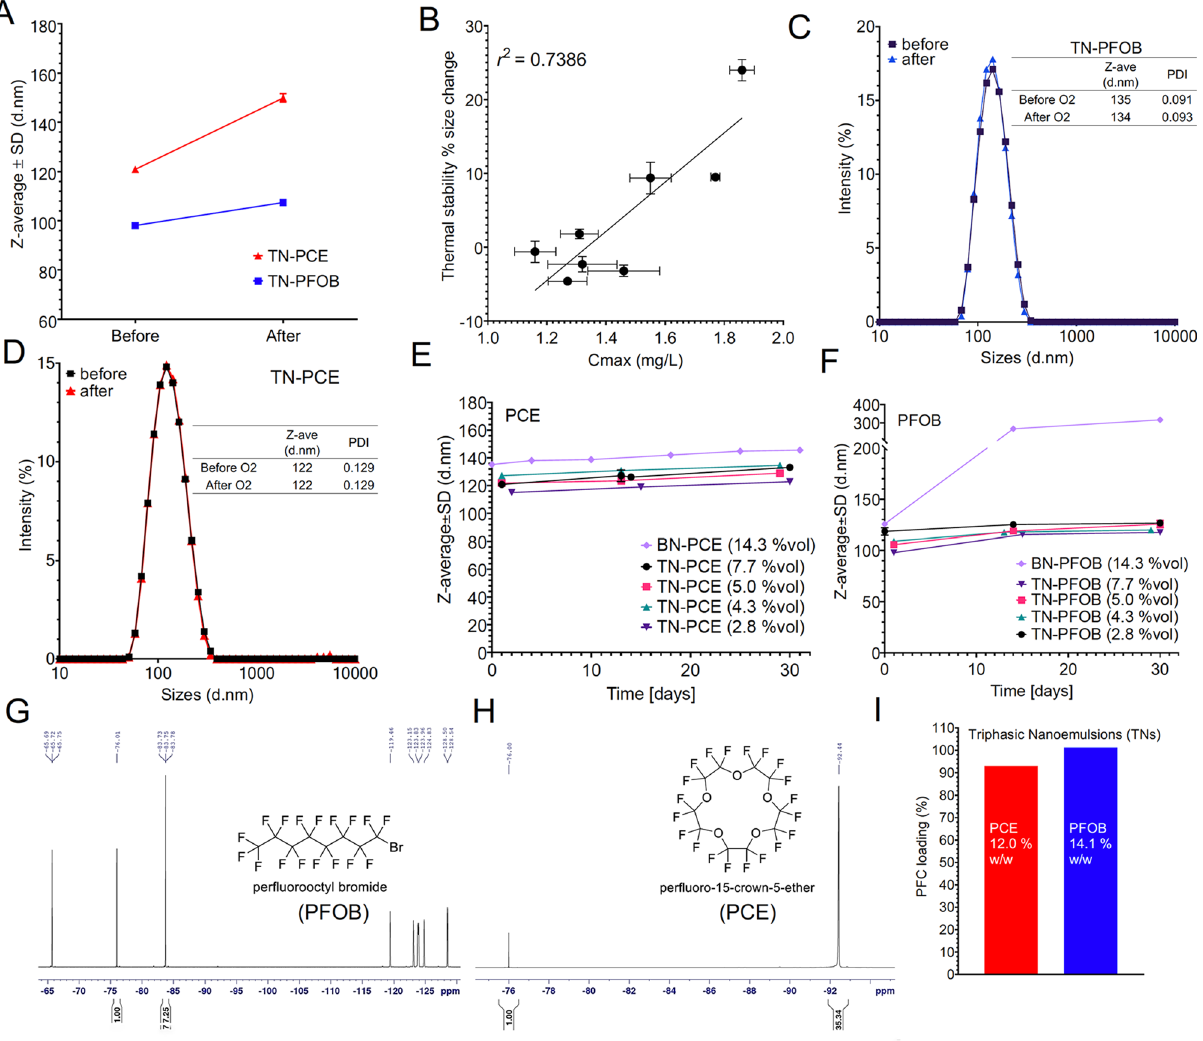
Figure 5. Characterization of triphasic PFC nanoemulsions. ( A ) For TNs, oxygen release is virtually identical among PFC types comparison in (see Fig. 4 ). Thermal stability Δsize for 2 representative samples shows a colloidal stability discrepancy exists between PFC types. ( B ) Least squares fit demonstrating the relationship of C max and Thermal stability Δsize. ( C , D ) Size distribution overlays reflect colloidal stability of TNs after 30 min of oxygen bubbling. ( E , F ) Shelf-stability reflected by z-average of samples stored at 4 °C. ( G , H ) 19 F NMR spectra of representative examples, TN3 and TN8 (TopSpin). Chemical drawings were done in ChemDraw. ( I ) PFC loading calculated from 19 F qNMR spectroscopy. Graphs were made in GraphPad